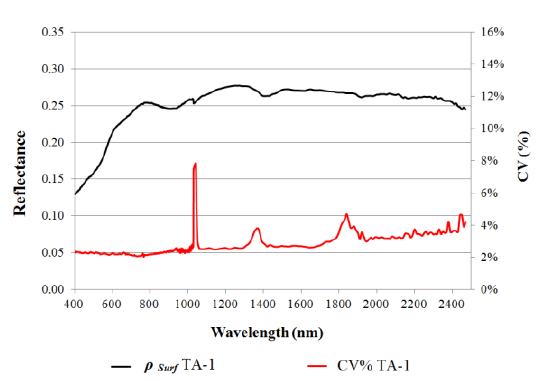
Figure 5. Surface reflectance of the Atacama calibration site. The peak of the CV observed around 1030 nm is located in the transition area of the Si and PbS detectors of the GER - 2600 spectroradiometer.